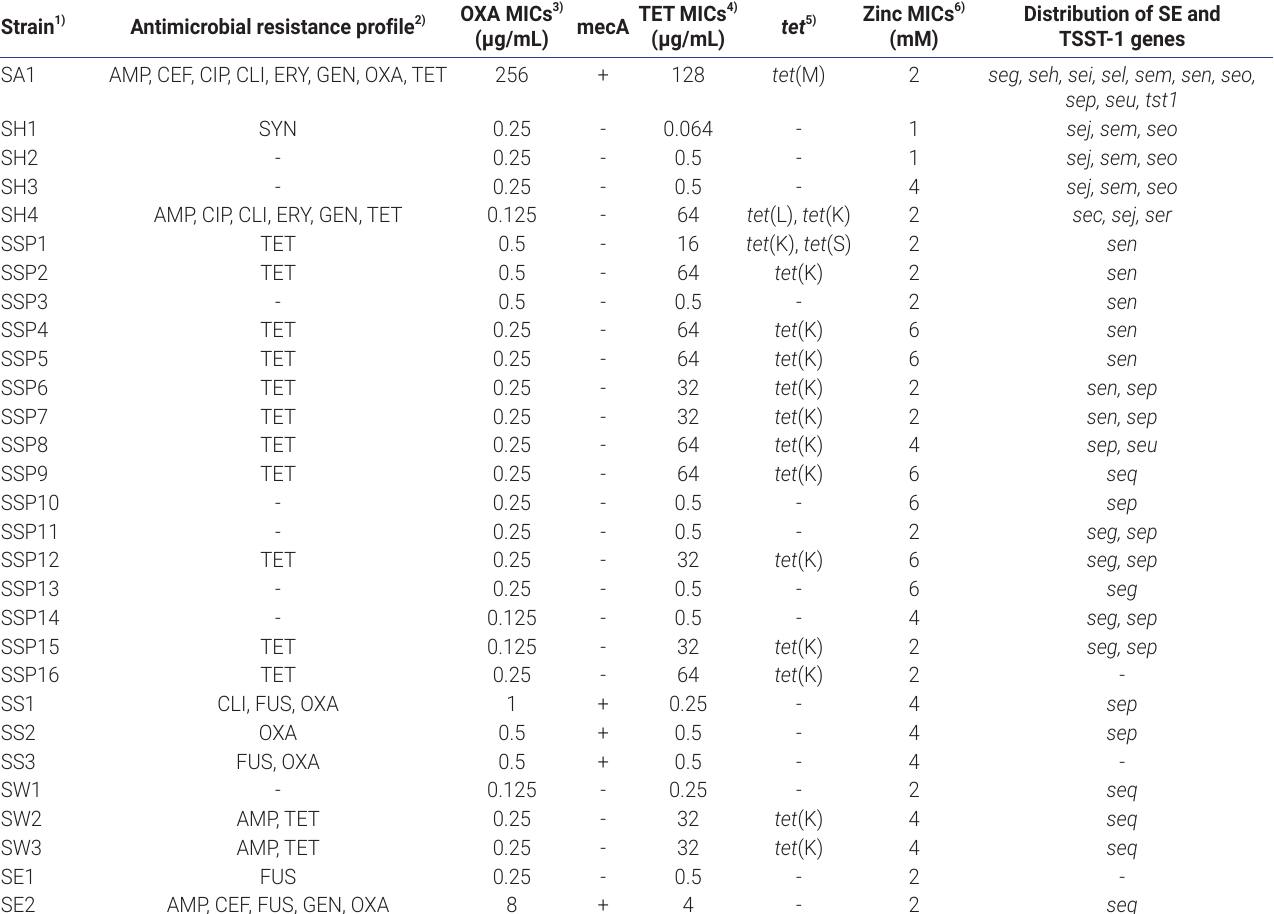
Table 3. Antimicrobial resistance profiles, resistance genes, and zinc chloride resistance in CoPS and CoNS isolated from pork meat